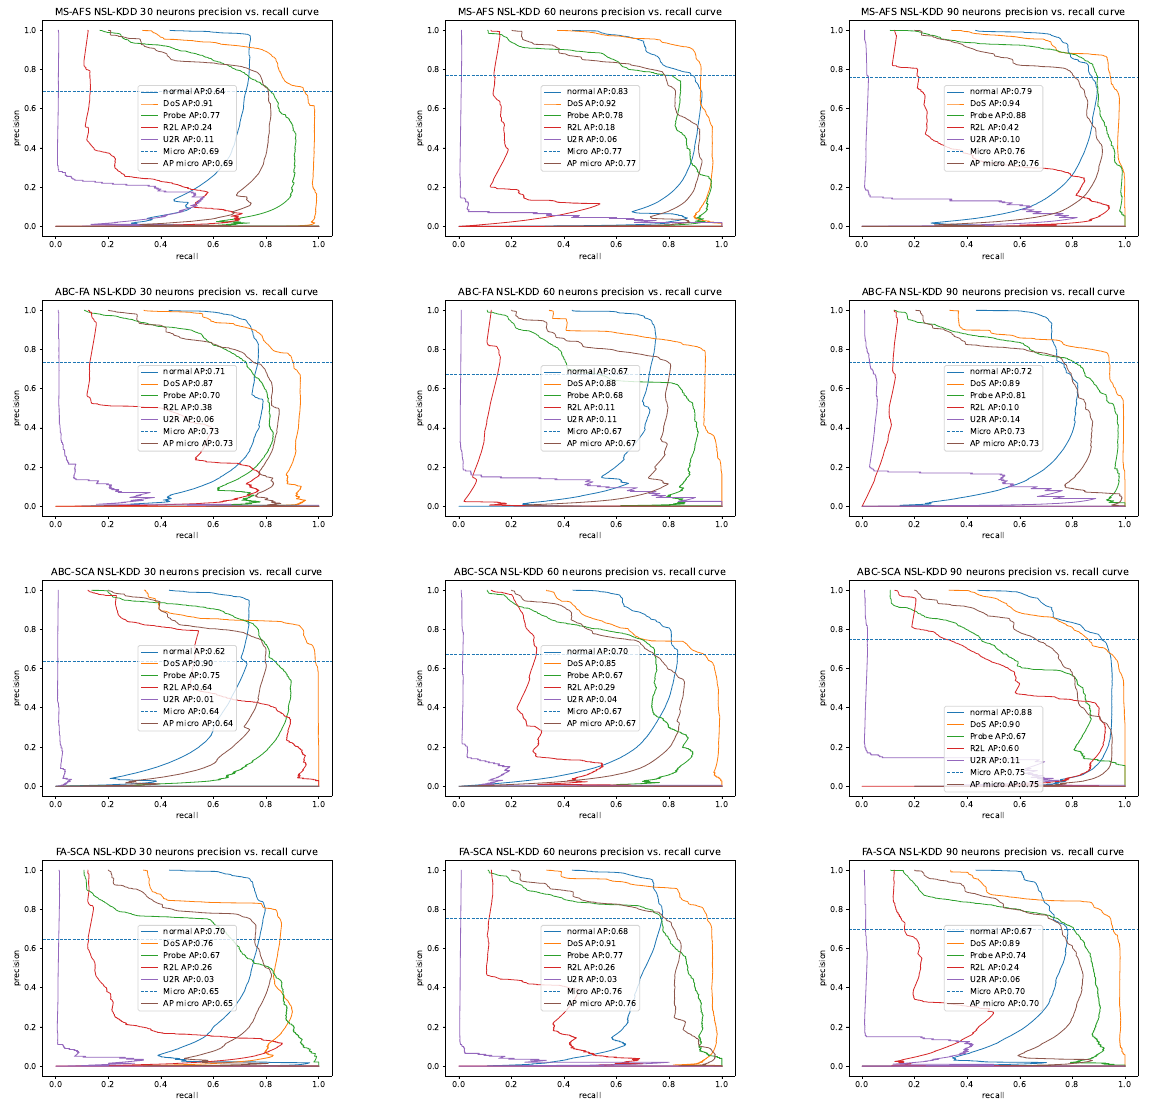
Figure 8. Generated PR curves for NSL-KDD dataset by hybrid